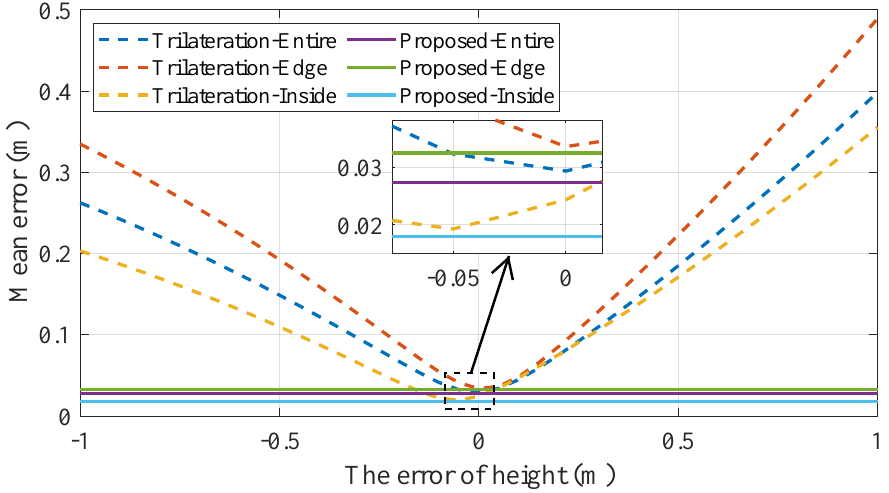
Figure 8. Horizontal positioning error at different a priori heights. The points inside (5 × 5) and the 24 points at the edges are evaluated